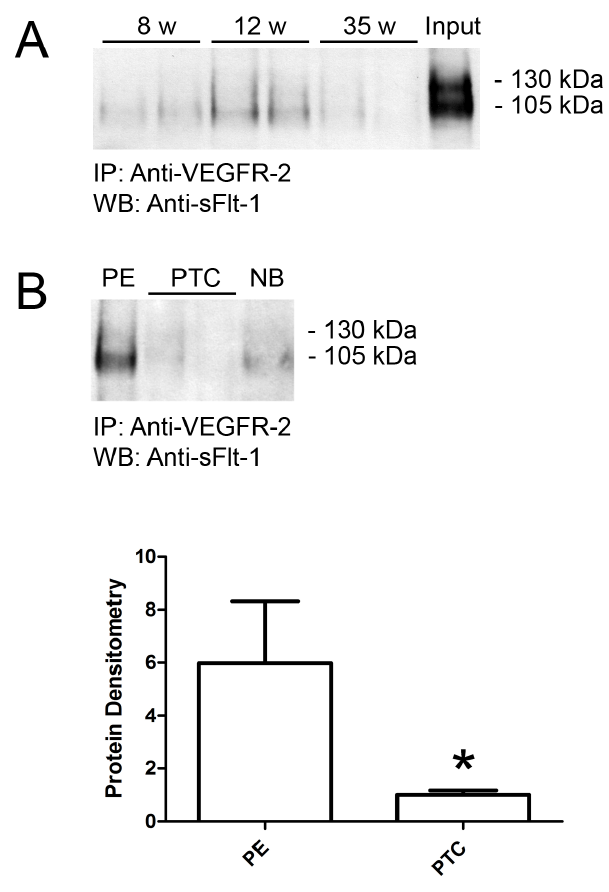
Figure 4. Increased association of VEGFR-2 and sFlt-1 in preeclamptic placentae. A: Representative sFlt-1 immunoblot of developmental placental samples (two different tissue samples at each gestational age of 8, 12 and 35 weeks) immunoprecipitated with a monoclonal VEGFR-2 antibody. A control lane of protein lysates prepared from placental tissue (35 weeks of gestation) is indicated (Input). B: Representative sFlt-1 immunoblot of PE and PTC samples immunoprecipitated with a monoclonal VEGFR-2 antibody. A negative control lane of PE protein lysate immunoprecipitated in the absence of VEGFR-2 antibody is indicated (NB). Densitometry analysis comparing sFlt-1 immunoreactivity between PE (n=3) and PTC (n=6) samples immunoprecipitated with VEGFR-2 antibody. (IP, immunoprecipitation antibody; WB, western blot antibody; PE, preeclampsia; PTC, age- matched preterm control; * P , 0.05). All values are represented as the means 6 SEM.